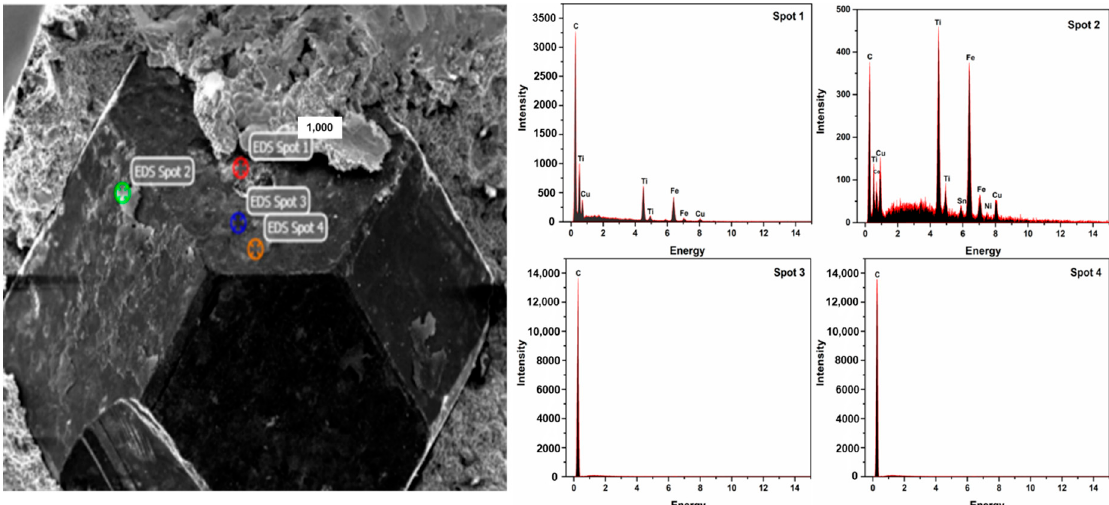
Figure 9. SEM-EDX analysis of samples sintered by MPS (900 °C, 395 MPa, 30 min).